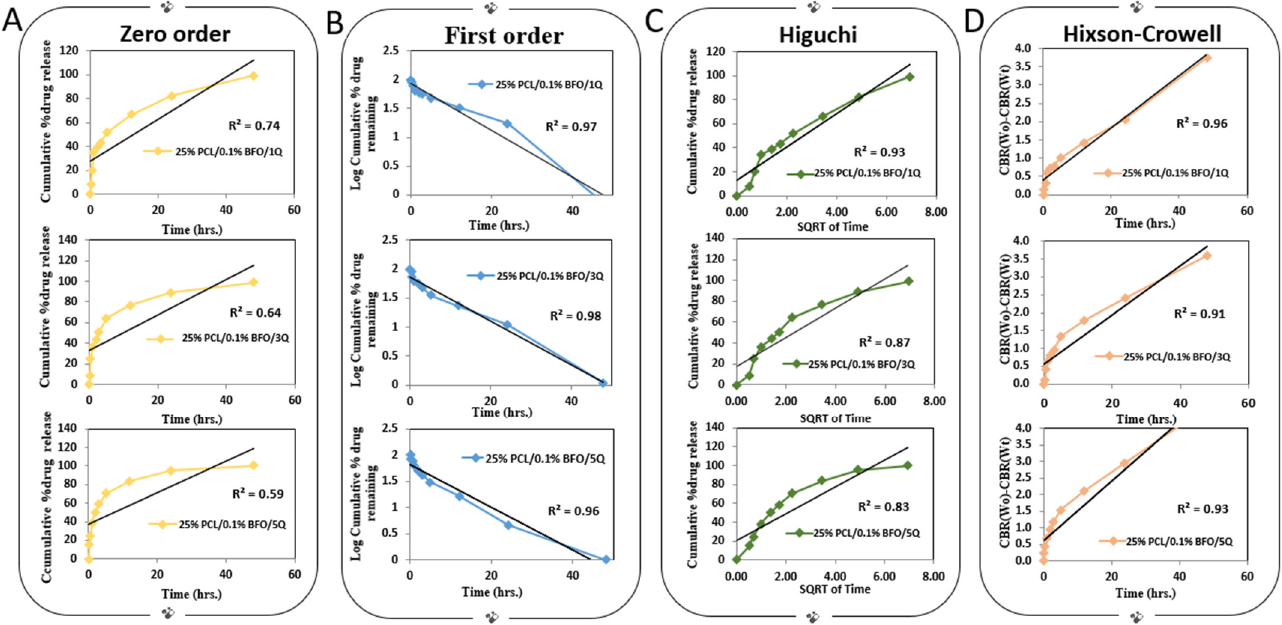
Figure 6. Drug-release studies of Q-loaded microfibrous scaffolds, zero-order drug-release kinetics ( A ), first-order drug-release kinetics ( B ), Higuchi drug-release kinetics ( C ), Hixson–Crowell drug- release kinetics ( D ).